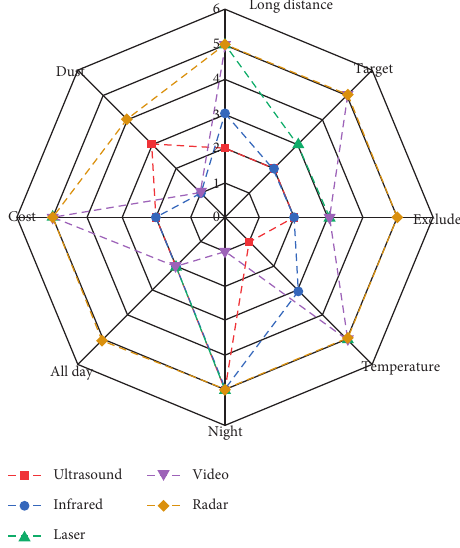
Figure 5: Sensor performance